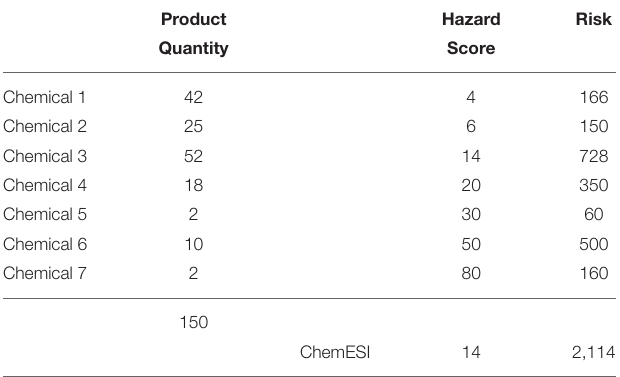
TABLE 4 | Chemical-based calculation of ChemESI. TABLE 5 | Chemical-based ChemESI following introduction of chemical 8.